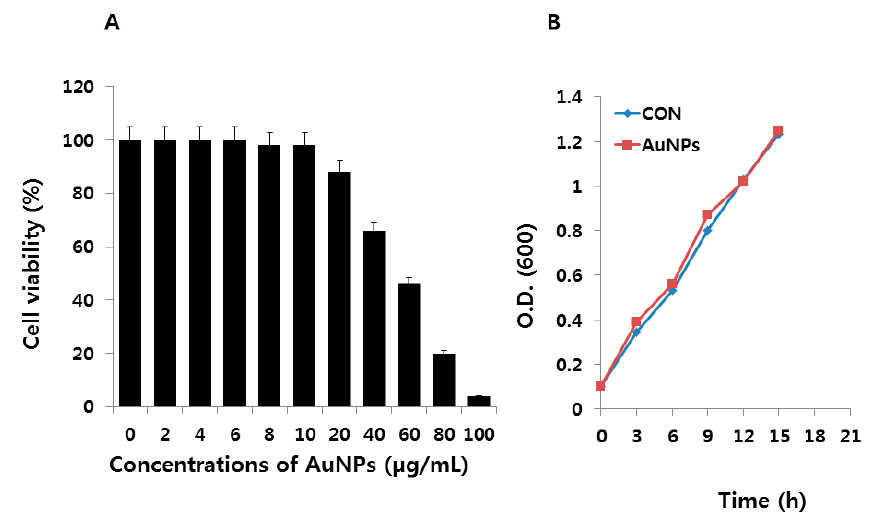
Figure 2. Effect of different concentrations of AuNPs and time on E. coli cell viability and growth. ( A ) E. coli cells were treated with AuNPs at various concentrations (from 0 to 100 μ g/mL) for 24 h, and cell viability was determined by the CFU method. Data are shown as means and standard deviations calculated from three independent experiments; ( B ) Cells were incubated with 1 μ g/mL of AuNPs. Samples were withdrawn at different points of growth, and the cells were centrifuged, washed with distilled water, and analyzed for growth at 600 nm. Data are shown as means and standard deviations calculated from three independent experiments.